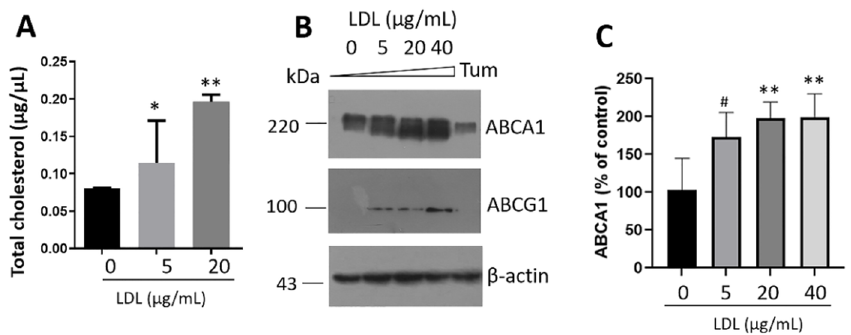
Figure 6. LDL treatment promotes the intracellular accumulation of cholesterol and triggers ABCA1 and ABCG1 expression. Intracellular cholesterol concentrations ( A ) on fat droplets under treatment with LDL (0–20 µg/mL) at 20 h. Results are reported as mean ± SD ( n = 3), * p < 0.1, ** p < 0.005. ( B ) Western blot of cholesterol transporters ABCA1 and ABCG1. β-actin was used as a loading control. Tunicamycin (Tum) was used as a control (1 µg/mL). ( C ) Densitometry analysis of ABCA1, results are reported as mean ± SD and expressed as % of control ( n = 3), # p < 0.05, ** p < 0.005.